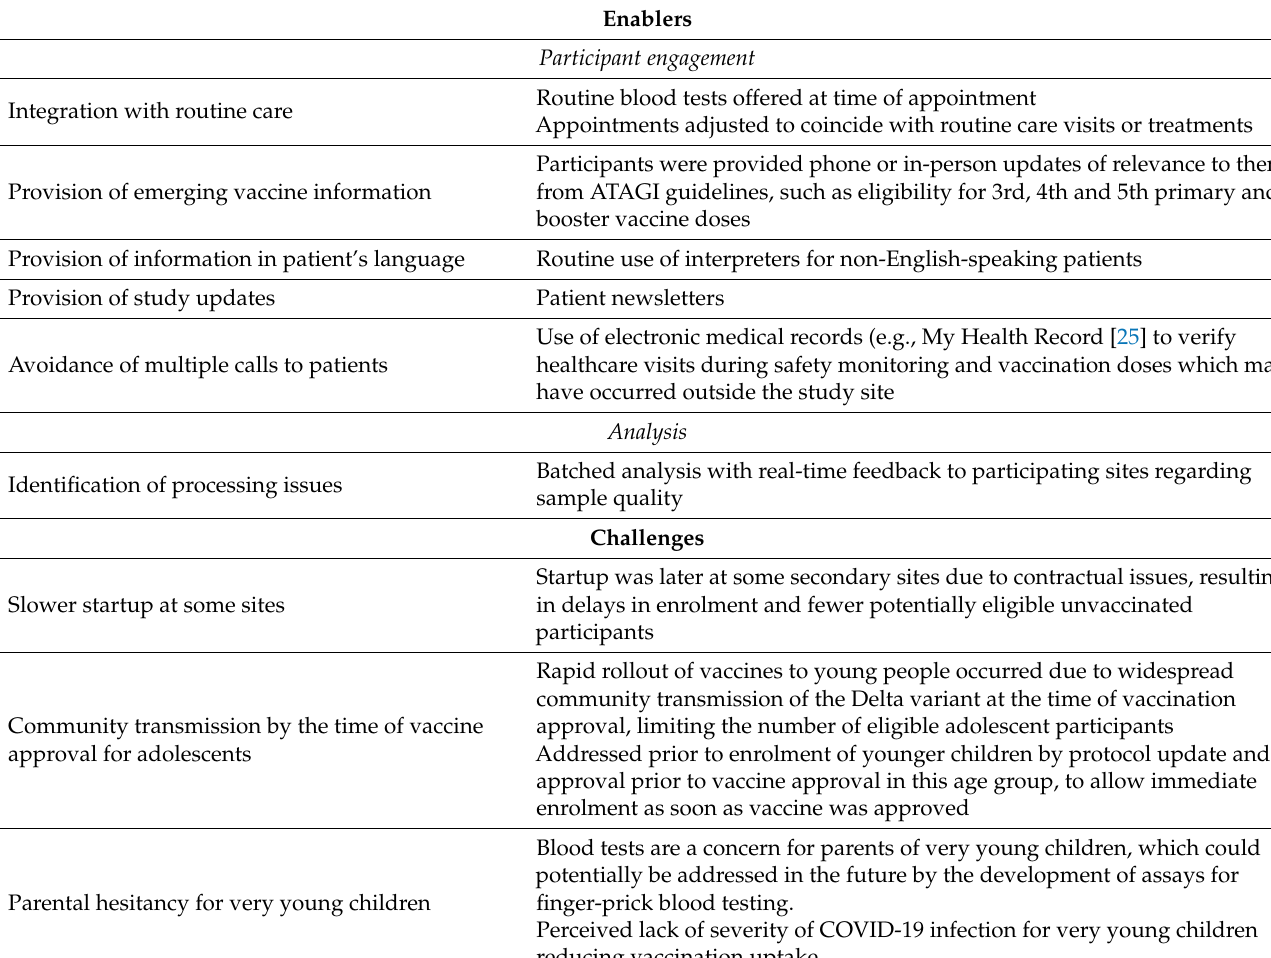
Table 3. Enablers and